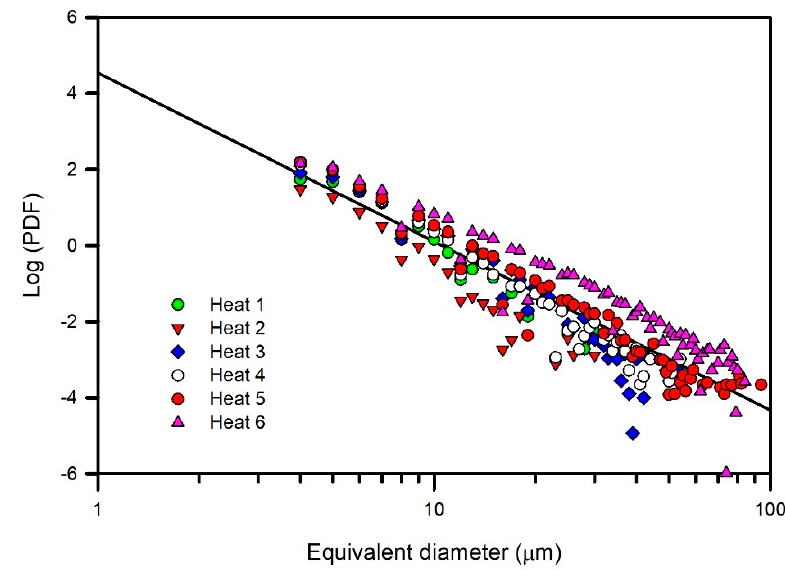
Figure 4. Log-log plots of PDFs versus inclusion equivalent diameter for all heats.